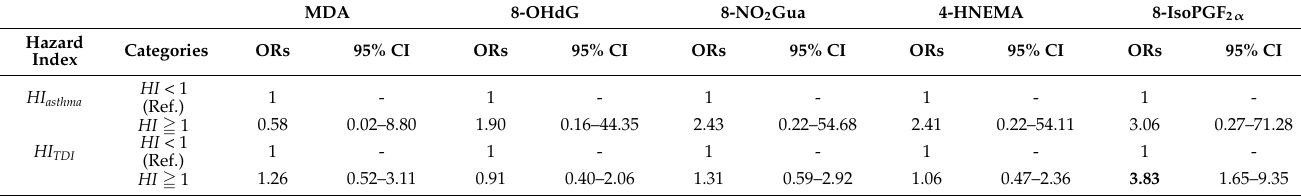
Table 7. Odds ratios a and 95% confidence intervals of higher b oxidative/nitrosative stress biomark- ers with different hazard indices (N =